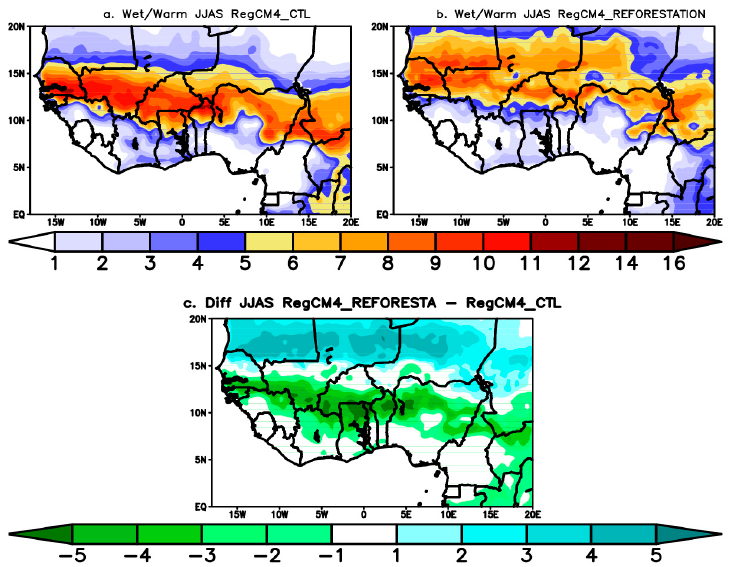
Figure 8. Number (expressed in days) of compound wet/warm during the JJAS period averaged from 1990 to 2009 over West Africa for: ( a ) RegCM4_CTL; ( b ) RegCM4_REFORESTATION and ( c ) RegCM4_REFORESTATION—RegCM4_CTL.